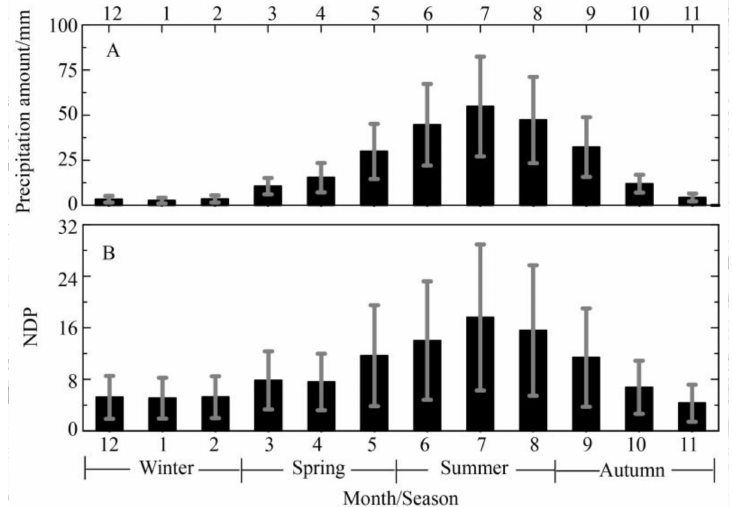
Figure 3. Monthly mean precipitation amount ( A ) and number of days with precipitation (NDP; ( B )) of 25 stations in HRB for 1984–2014 (error bar denotes maximum to minimum of 25